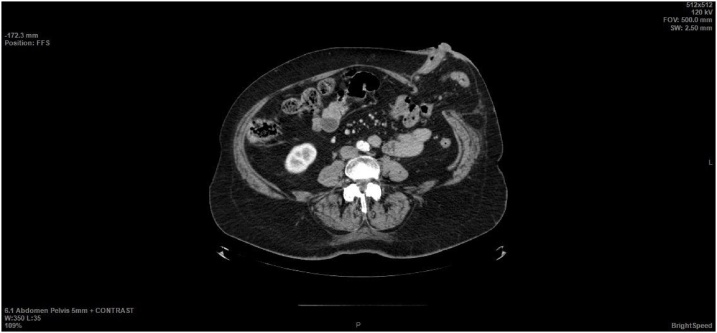
Abdominal CT scan.